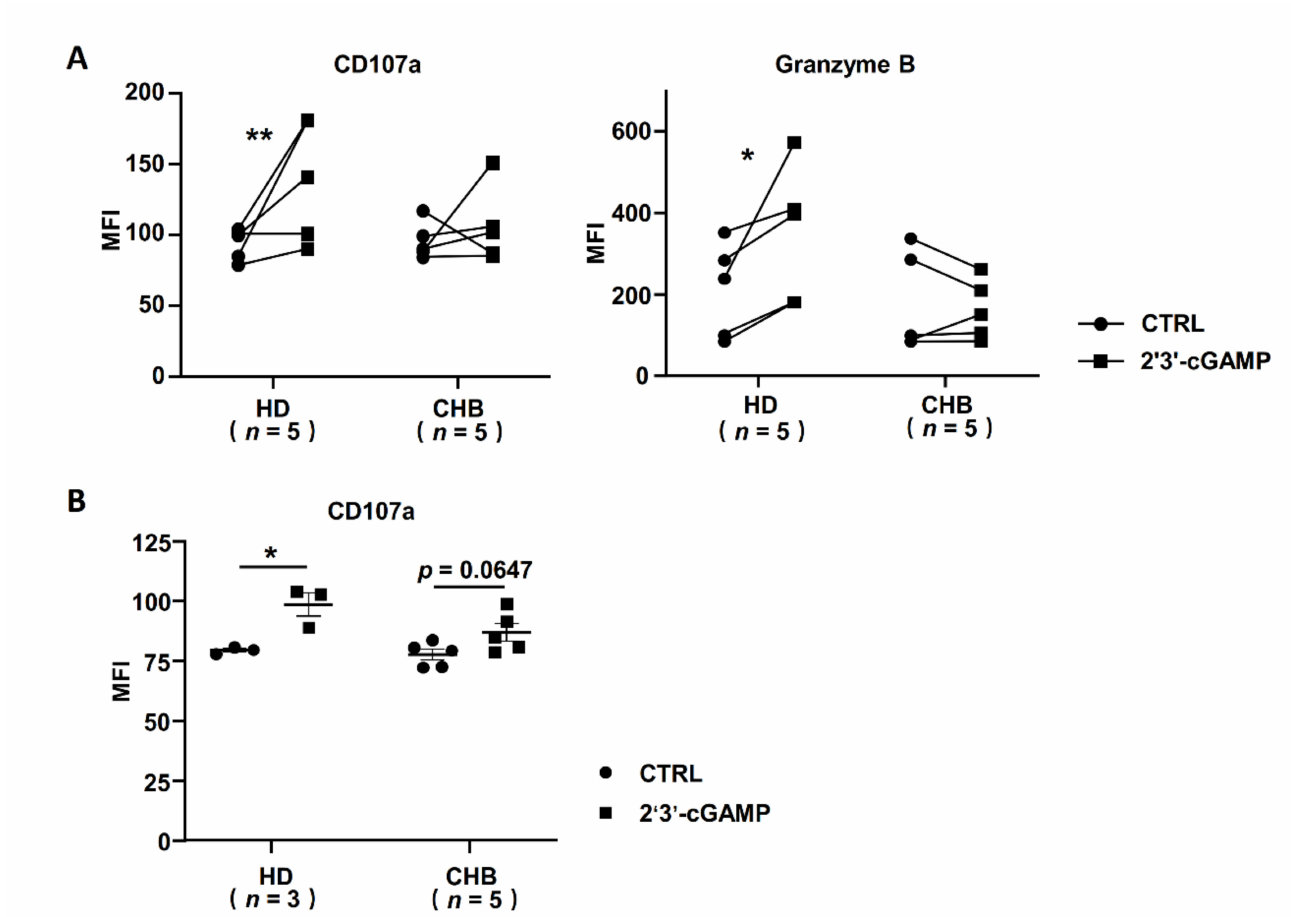
Figure 2. The response of STING in NK cells was significantly decreased in CHB patients. ( A ) The levels of CD107a and Granzyme B in NK cells of HD and CHB patients incubated with 2 (cid:48) 3 (cid:48) -cGAMP for 6 h. ( B ) The CD107a levels of NK-92 cells incubated with serum of HD and CHB patients for 48 h and then stimulated with 2 (cid:48) 3 (cid:48) -cGAMP for 6 h were analyzed by FACS. Data are shown as mean ± SEM. The statistically significant difference between two groups was determined by a t -test. * p < 0.05; ** p < 0.01. CHB, CHB patients; HD, healthy donors; NK, natural